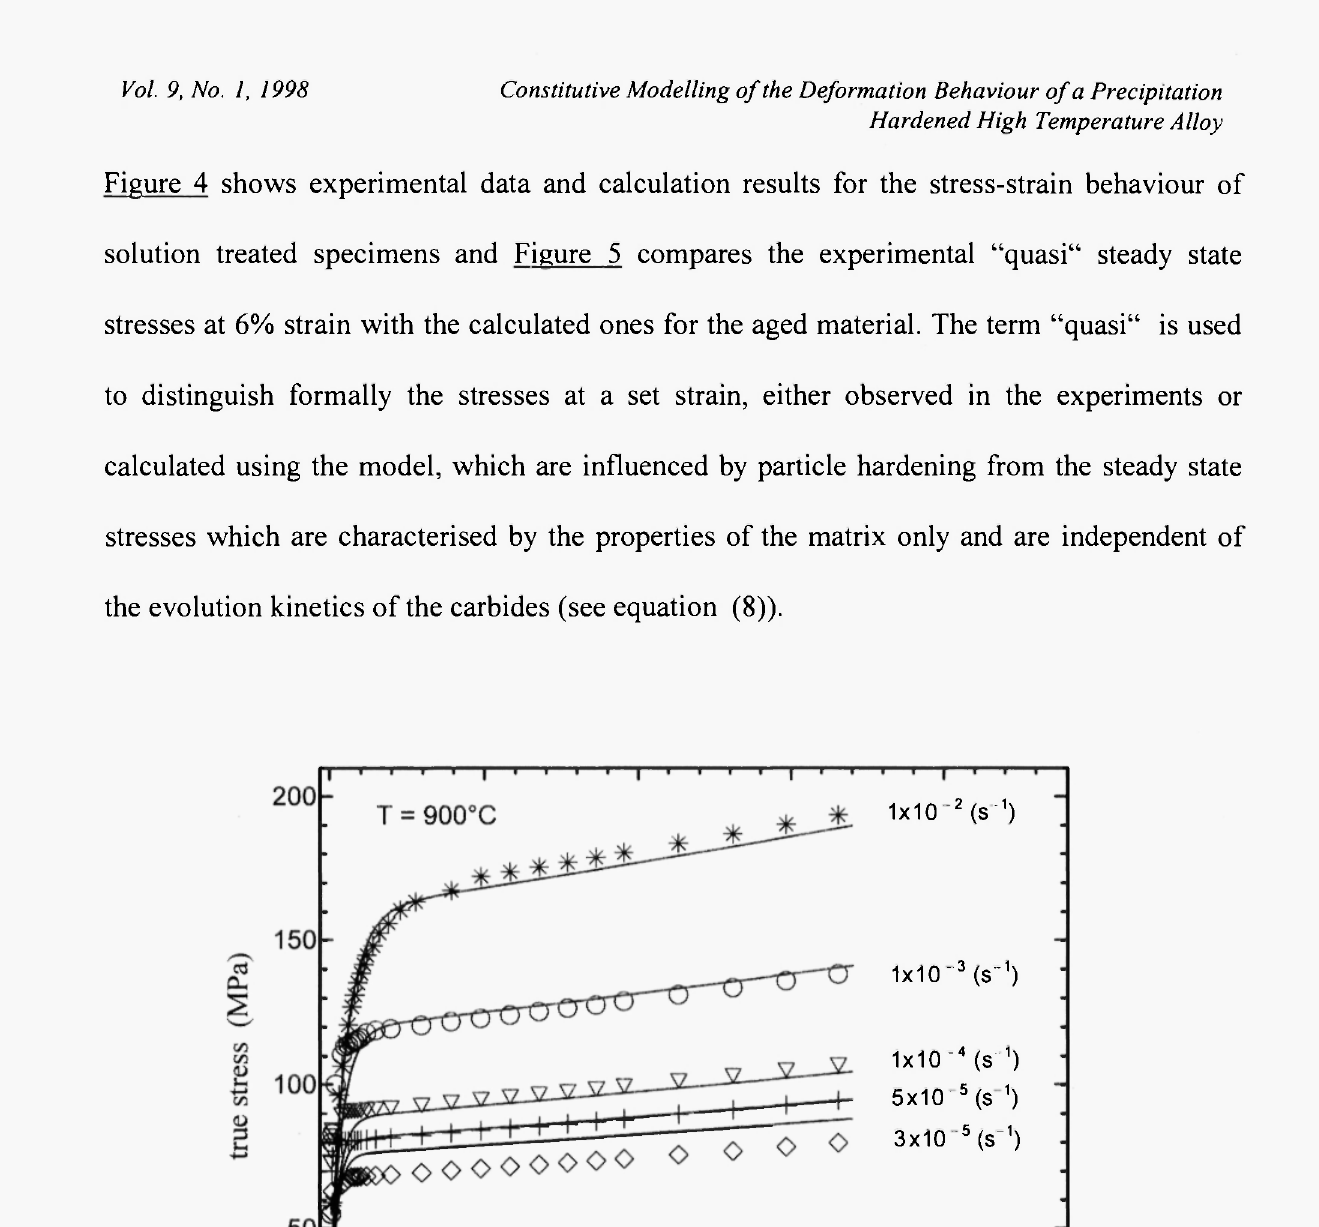
Figure 4: Model calculations (solid lines) and experimental stress-strain curves for solution treated specimens